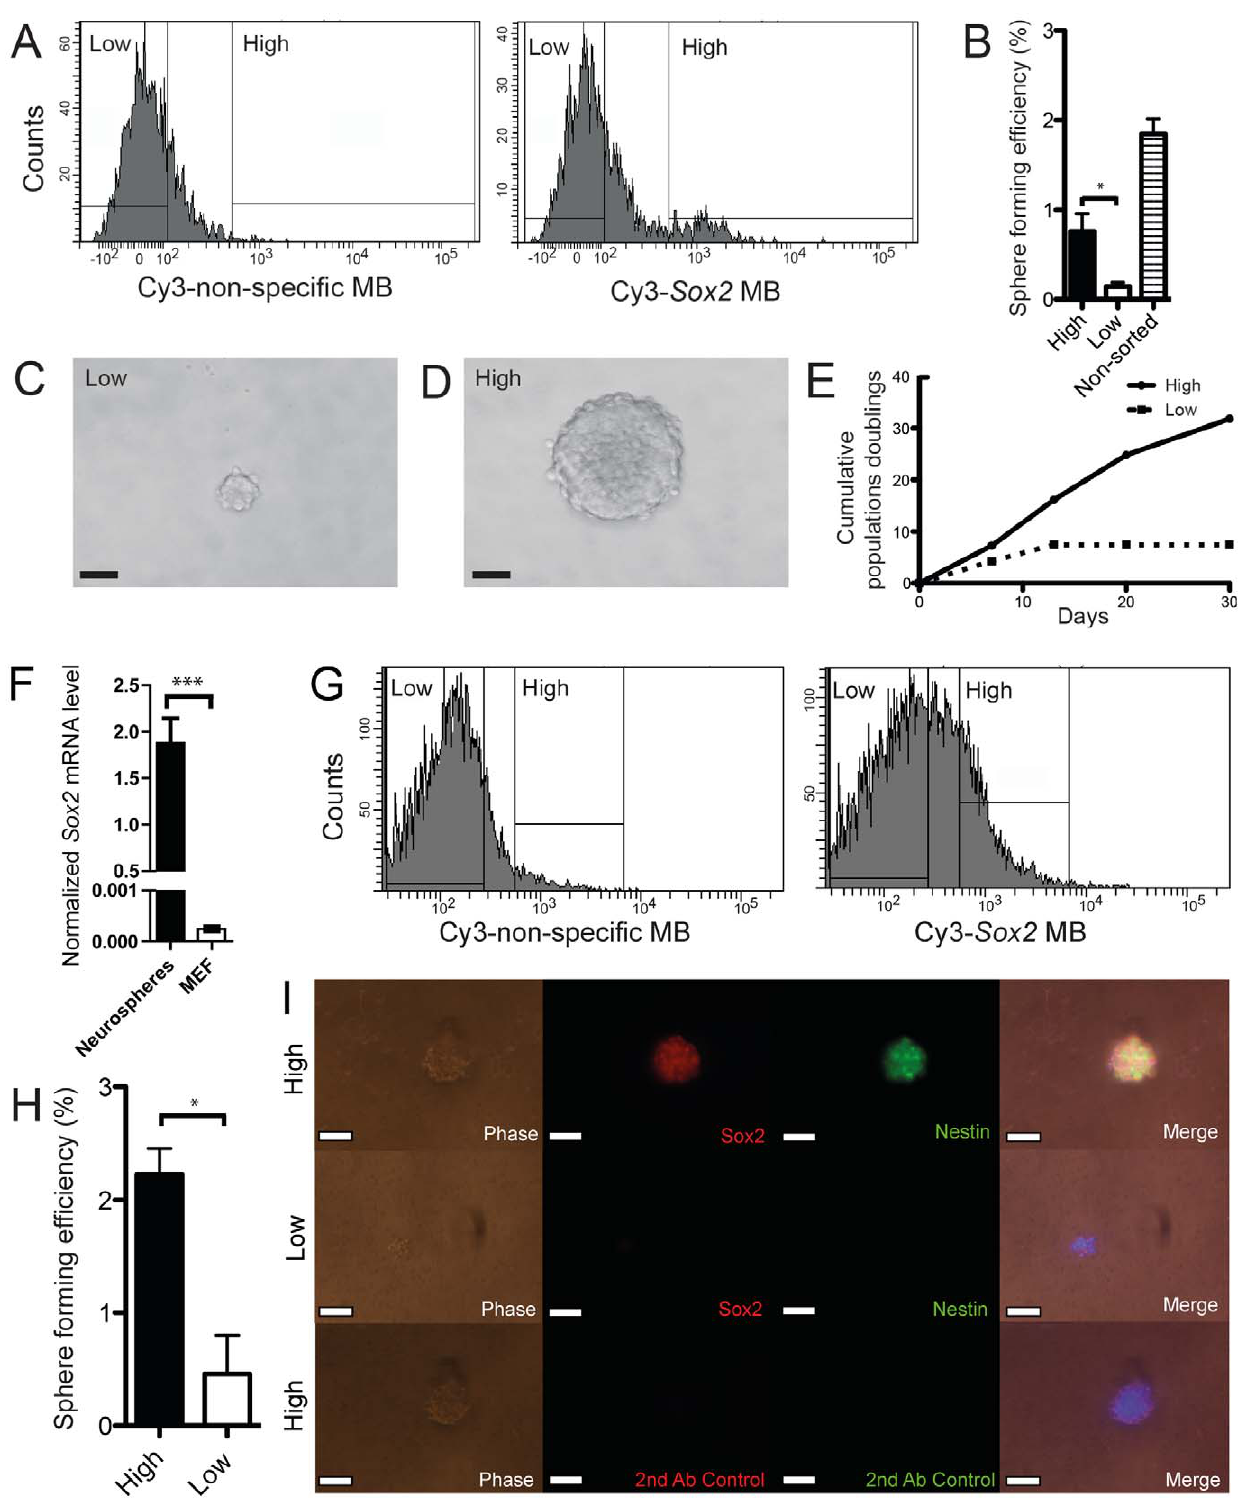
Figure 4. Isolation of neurospheres from primary mouse tissue and of invitro cultured neurospheres using Sox2- MB. (A) Two cell populations, namely Sox2- MB high and the Sox2- MB low , were first selected on Annexin-V - cells and then by comparing the nonspecific-MB fluorescent signal to the Sox2-MB fluorescent signal. (B) After 1 wk, sphere-forming efficiency was calculated from the Sox2- MB high and the Sox2- MB low populations as well as non-sorted primary mouse hippocampus isolated cells. (C and D) Images of 1 wk old spheres generated from sorted Sox2- MB low cells and Sox2- MB high cells (scale bar =25 m m). (E) Neurospheres from the Sox2- MB high and the Sox2- MB low populations were serially passaged and cumulative population doublings was calculated. (F) In vitro cultured neurosphere mRNA expression of Sox2 was analyzed by RT-PCR and compared to MEFs. (G) Two cell populations, namely Sox2 -MB high and Sox2- MB low , were selected by comparing the nonspecific-MB fluorescent signal